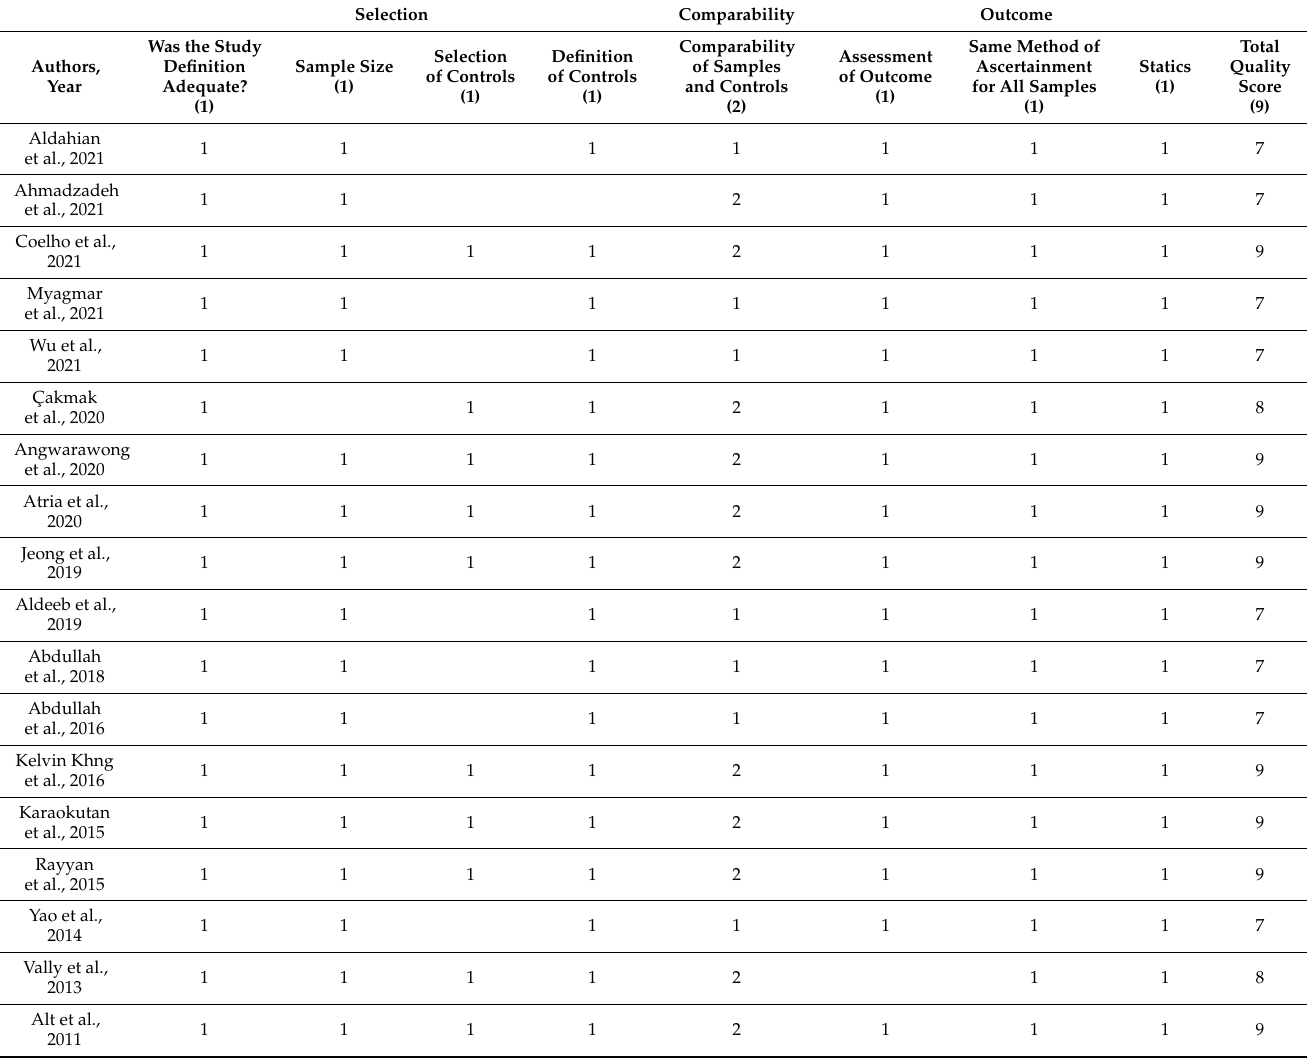
Table 2. Newcastle–Ottawa bias assessment for non-RCT.